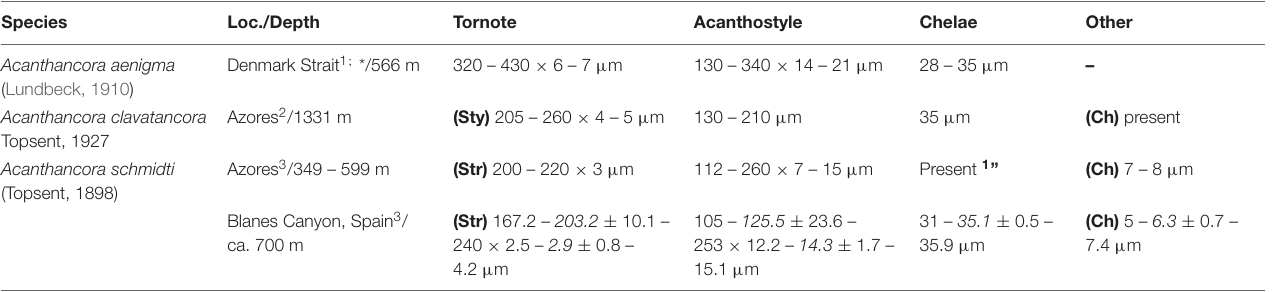
TABLE 4 | Comparative table between the North Atlantic Acanthancora , including the locality (Loc.) and depth of the sample, as well as the measurement of their spicular complement. Species Loc./Depth